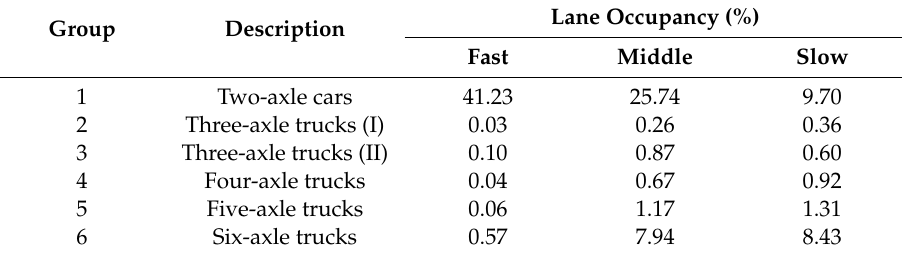
Figure 7. Vehicle model in the observation model. Table 3. Vehicle groups and occupancy rate in the observation model.